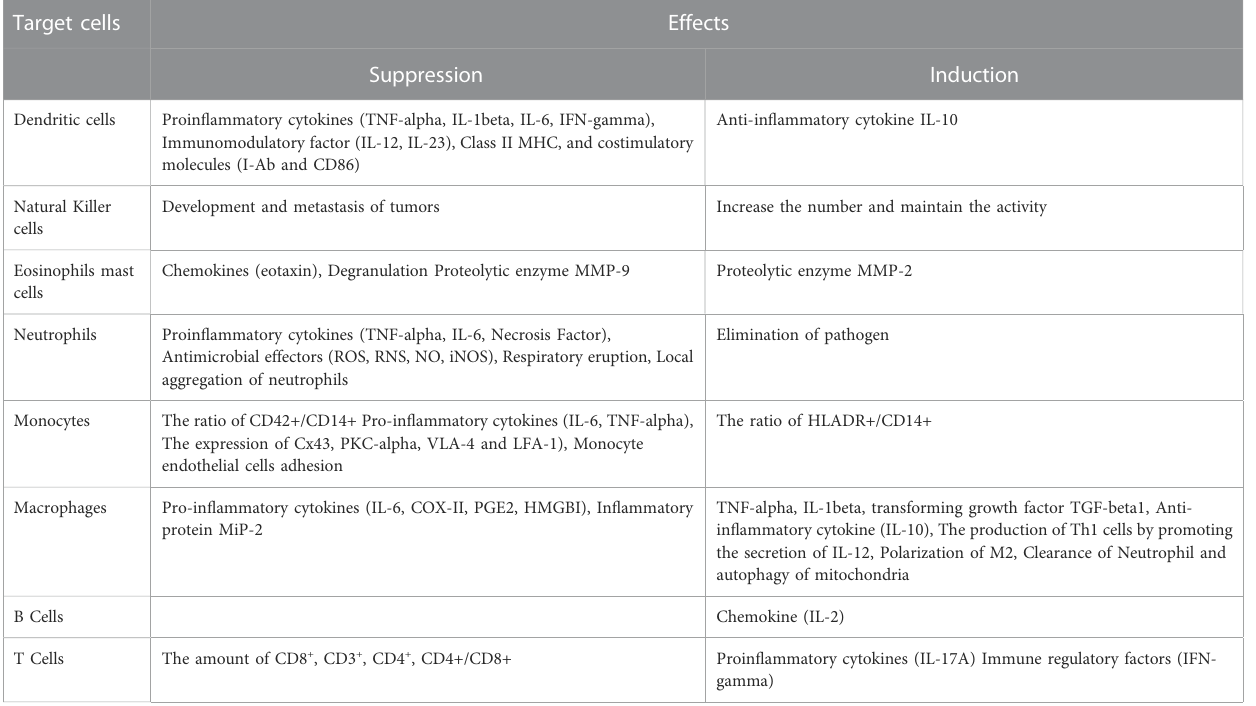
TABLE 1 A summary of Dexmedetomidine ’ s effects on immune cells. Adapted from R. Chen et al., “ Effects of Dexmedetomidine on Immune Cells: A Narrative Review, ” Frontiers in Pharmacology, vol. 13, no. 3 May 2022, doi: 10.3389/fphar.